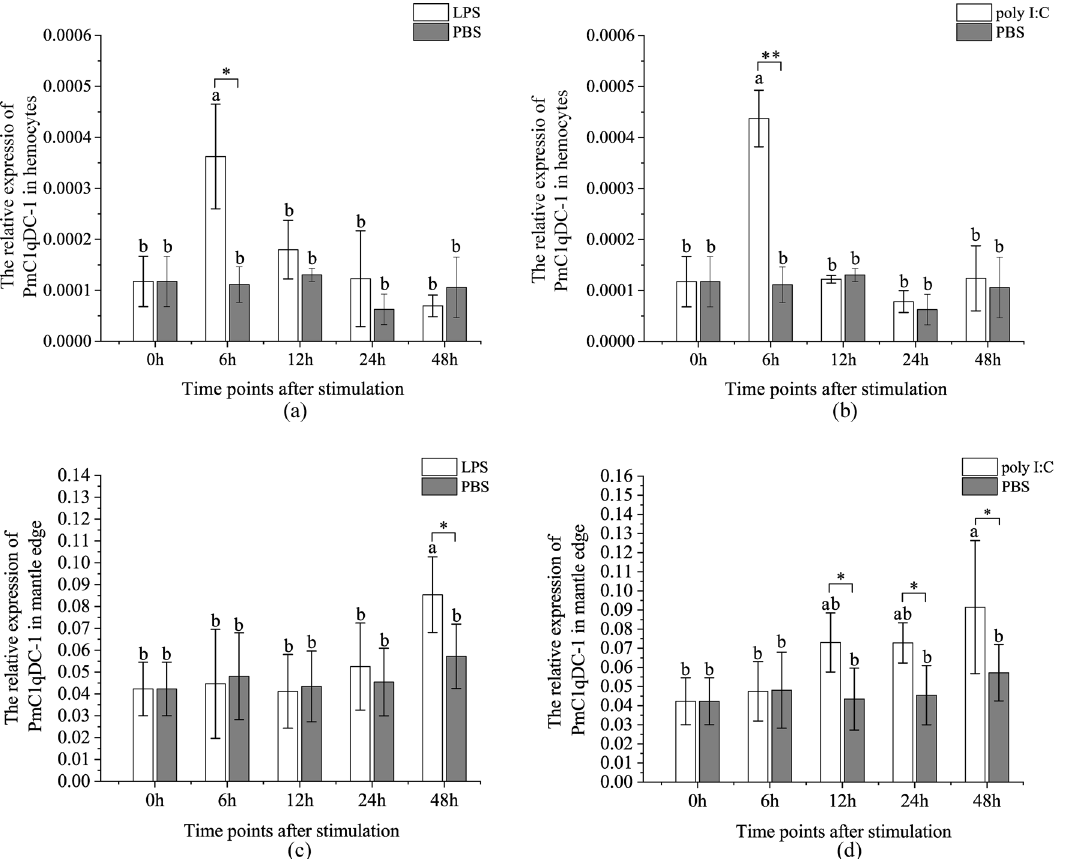
Figure 9. Expression pattern of PmC1qDC-1 after immune challenge. ( a ) Expression pattern of PmC1qDC-1 in hemocytes after LPS injection. ( b ) Expression pattern of PmC1qDC-1 in hemocytes after poly I:C injection. ( c ) Expression pattern of PmC1qDC-1 in mantle after LPS injection. ( d ) Expression pattern of PmC1qDC-1 in mantle poly I:C injection. The averages of the groups with the different lower-case letters (a, b, c) are significantly different (P < 0.05). The averages of the groups with the same lower-case letters (a, b, c) were not significantly difference (P > 0.05). *Significant difference in expression between the two groups at the same time point (P < 0.05). **That the expression levels between the two groups are extremely significant at the same time point (P <